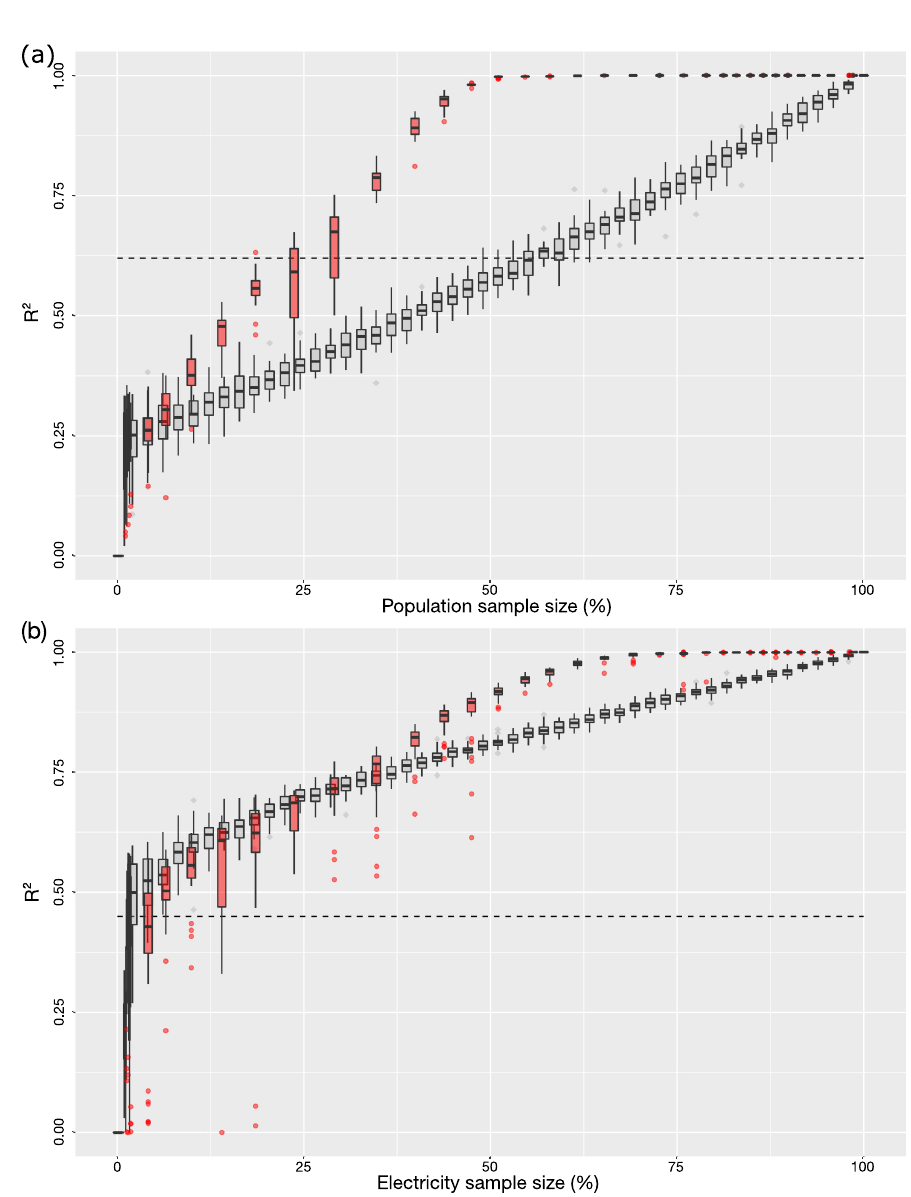
Fig 3. Recovering population density and nighttime lights from a sample of reference mobile phone activity curves. (a) Population density. (b) Nighttime lights intensity. The grey boxes are for a sample randomly chosen among all curves. The red boxes are for a sample selection guided by the daily number of texts profile clustering tree. The best direct correlation from Table 1 for each case is represented as a horizontal dash lines. All four cases have been tested 30 times to build the boxes (lower and upper quartiles) and